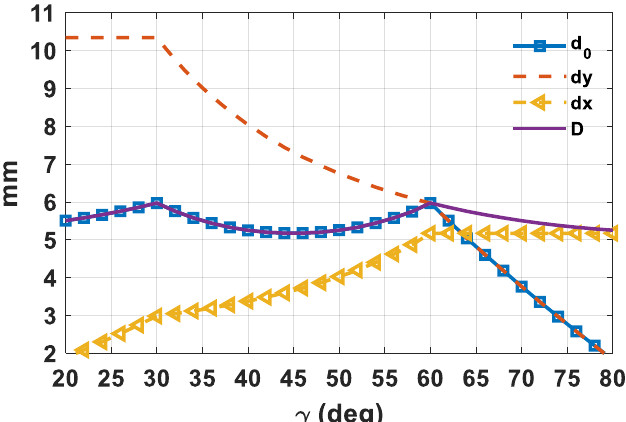
Figure 4. Elements’ spacing ( d x , d y ), the antenna elements’ distance ( D ), and its minimum ( d 0 ) as a function of the γ value for a triangular lattice array in the event of R =